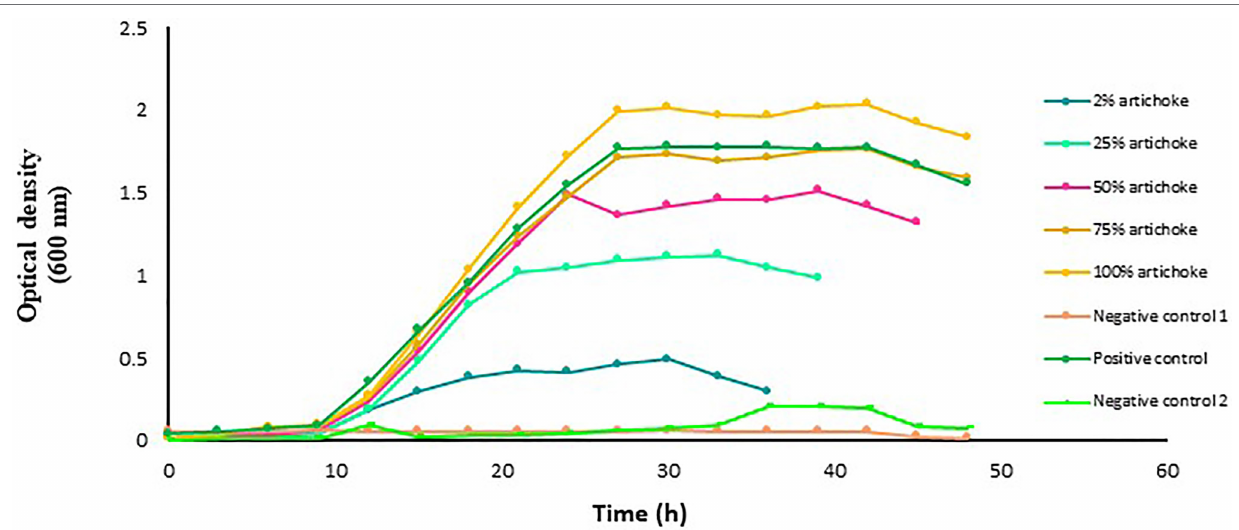
FIGURE 3 | Growth of Lactobacillus delbrueckii subsp. bulgaricus in MRS broth medium with and without artichoke extract added at an increasing concentration of 2, 25, 50, 75, or 100%. Lactobacillus acidophilus grown in MRS broth medium with a standard amount of glucose served as a positive control. The glucose-free